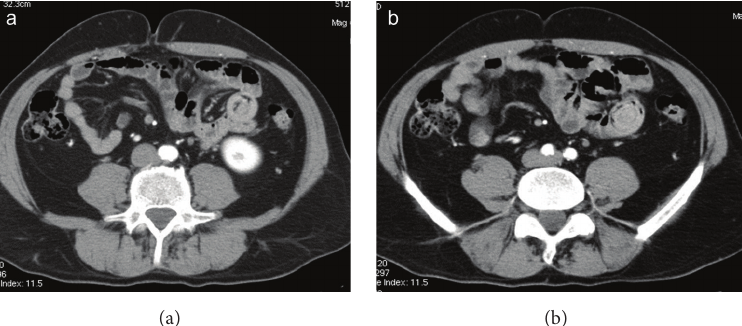
Figure 6: Enteroenteric (ileoileal) transient intussusception in a traumatized patient. Axial CT images oriented perpendicular to the longitudinal plane of the intussusception demonstrate the typical multilayered appearance of small bowel intussusception. Heterogeneous “target”masswiththeintussuscipiens,intussusceptum,andvesselswithintheinvaginatedmesentericfat.Nosignsofsignificativeobstruction, only mild stasis in the small bowel.